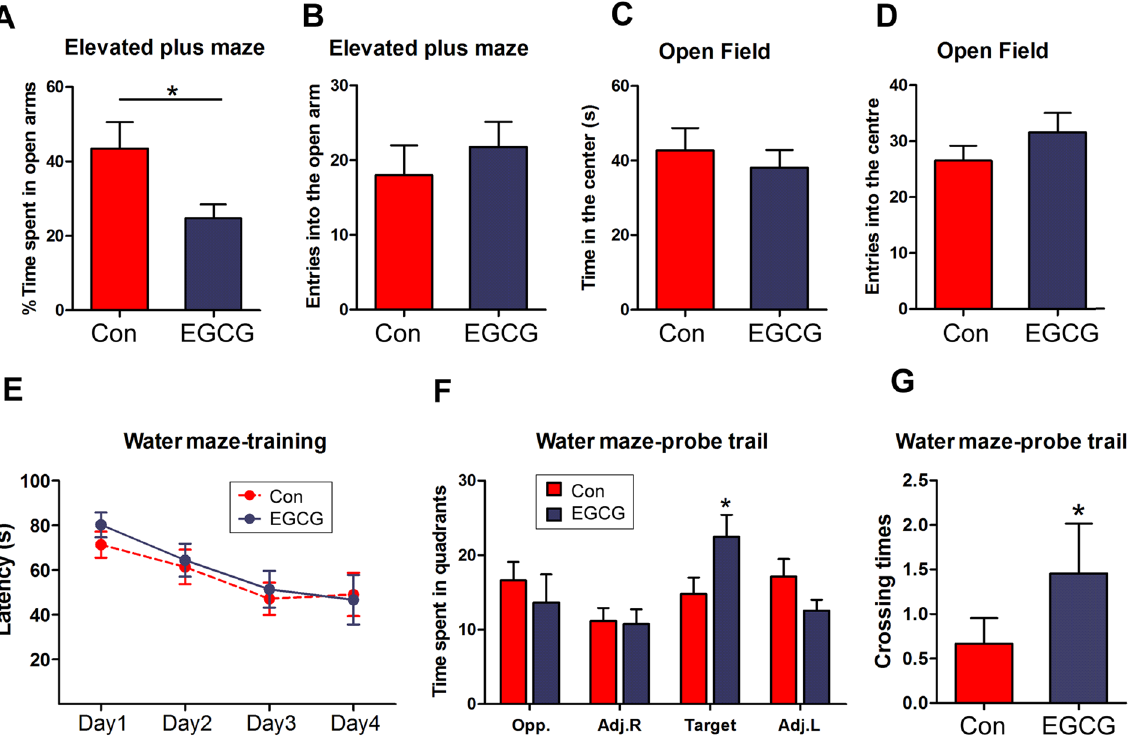
Figure 7. EGCG rescues the impaired behavior of Ts65Dn. Ts65Dn mice were treated with EGCG treatment from prenatal to adulthood and subjected to elevated plus maze ( A,B ), open field test ( C,D ), and Morris water maze test ( E–G ). The data were presented as mean ± SEM (n = 9–13) and analyzed by student t test. * p <